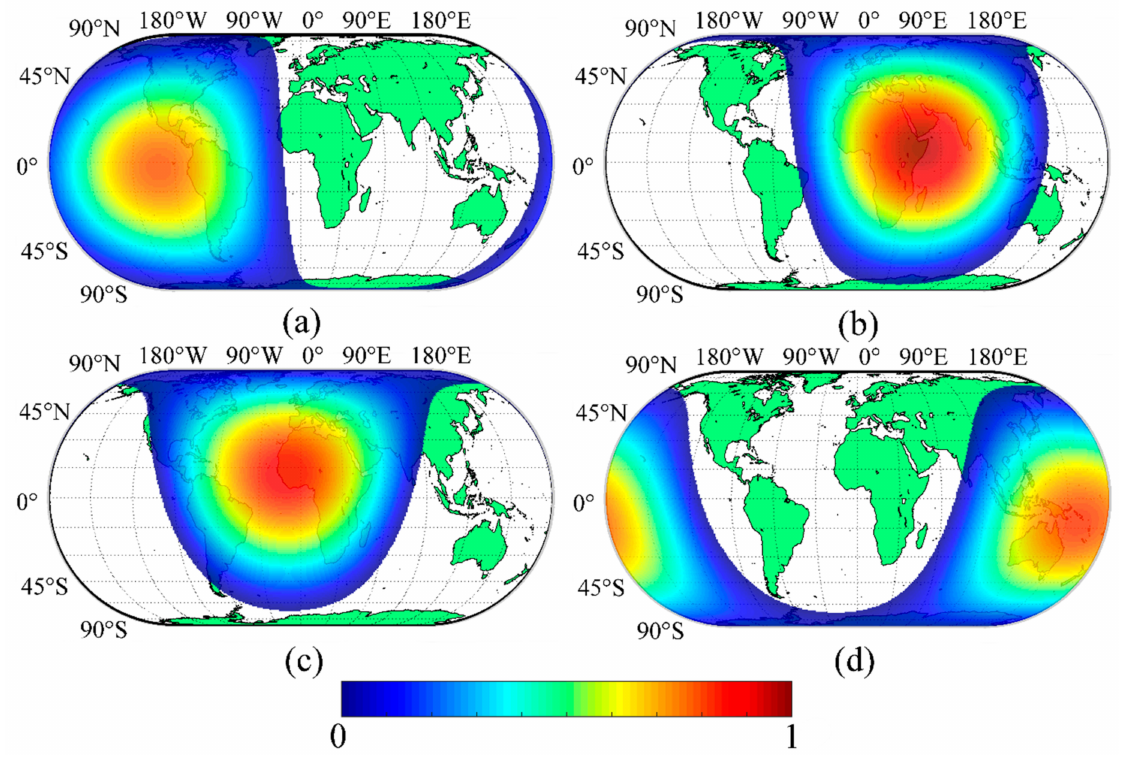
Figure 8. Distribution of the normalized geometric factor with the Moon at ( a ) perigee, ( b ) apogee, ( c ) maximum inclination above the Earth equator plane, and ( d ) maximum inclination below the Earth equator